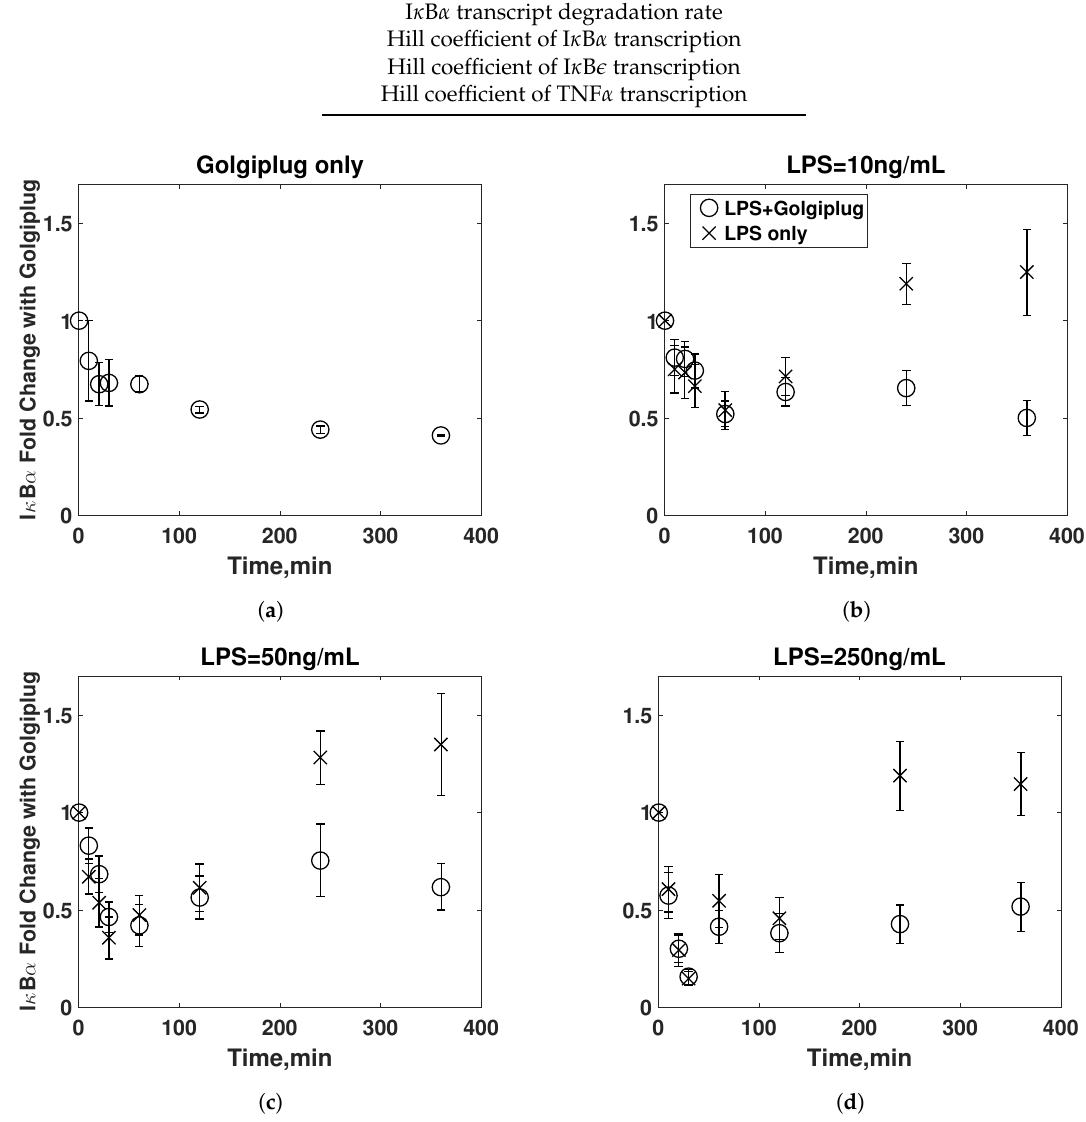
Figure 3. Kinetics of I κ B α fold changes when the cells were stimulated by ( a ) 0, ( b ) 10, ( c ) 50, and ( d ) 250 ng/mL of LPS in the presence (empty circles) or absence (x marks) of Golgiplug ™ . Data are given as means ± SEM with at least n =